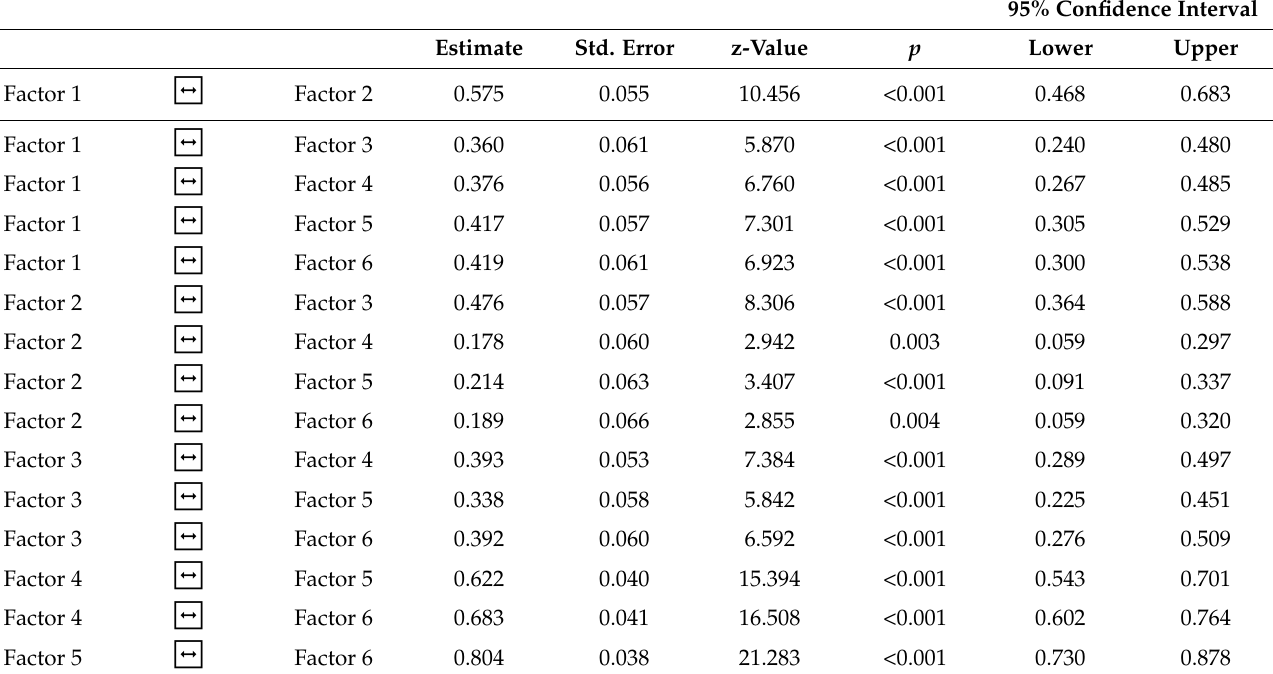
Table 8. Scale Reliability Statistics.